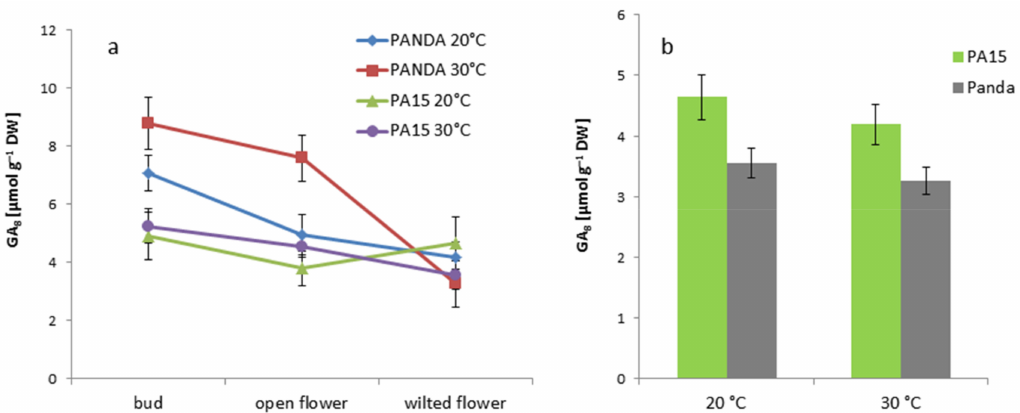
Figure 7. Content of non-active gibberellin GA 8 [ µ mol g − 1 DW] in the flower buds, open flowers, and wilted flowers ( a ) and the leaves ( b ) of the ‘Panda’ and PA15 plants grown at 20 ◦ C (control) and 30 ◦ C (thermal stress). Means ( n = 3) ±